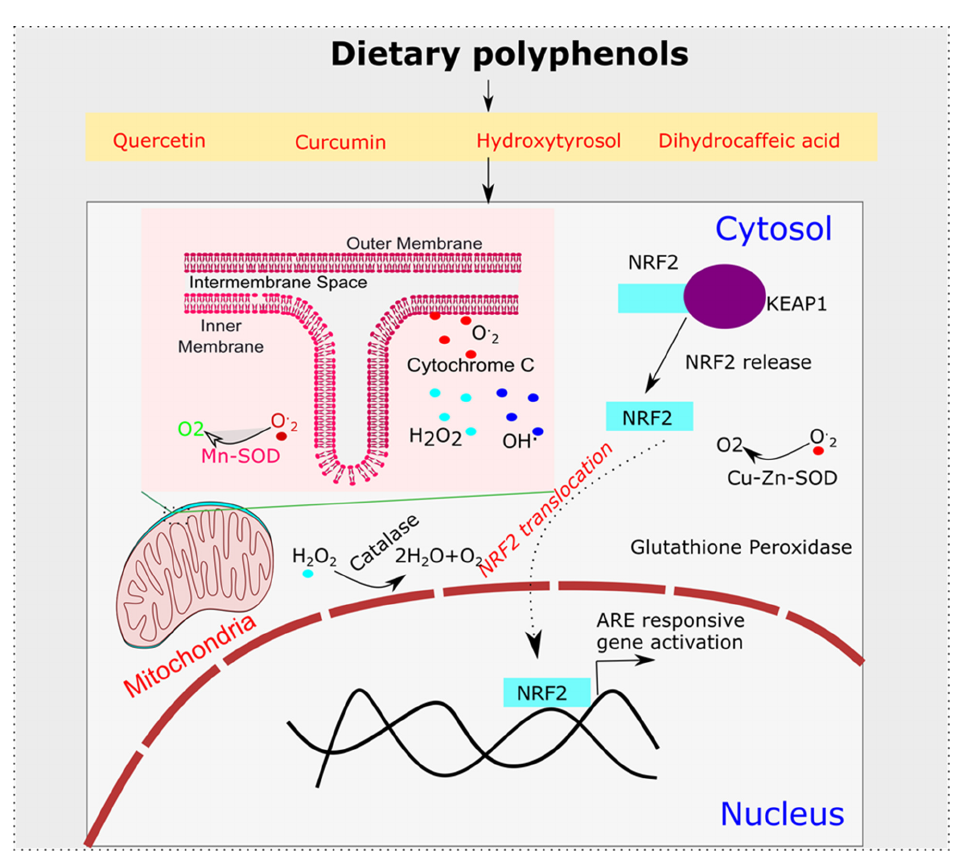
Figure 4. Dietary Polyphenols’ Anti-Oxidative Mechanism. Mostly dietary polyphenols’ basic mechanism of action involves their role as antioxidant which can be achieved by modulating NRF2- KEAP1 antioxidant response pathway or through modulation of antioxidant enzyme, such as SOD (Superoxide Dismutase), Catalase and Glutathione